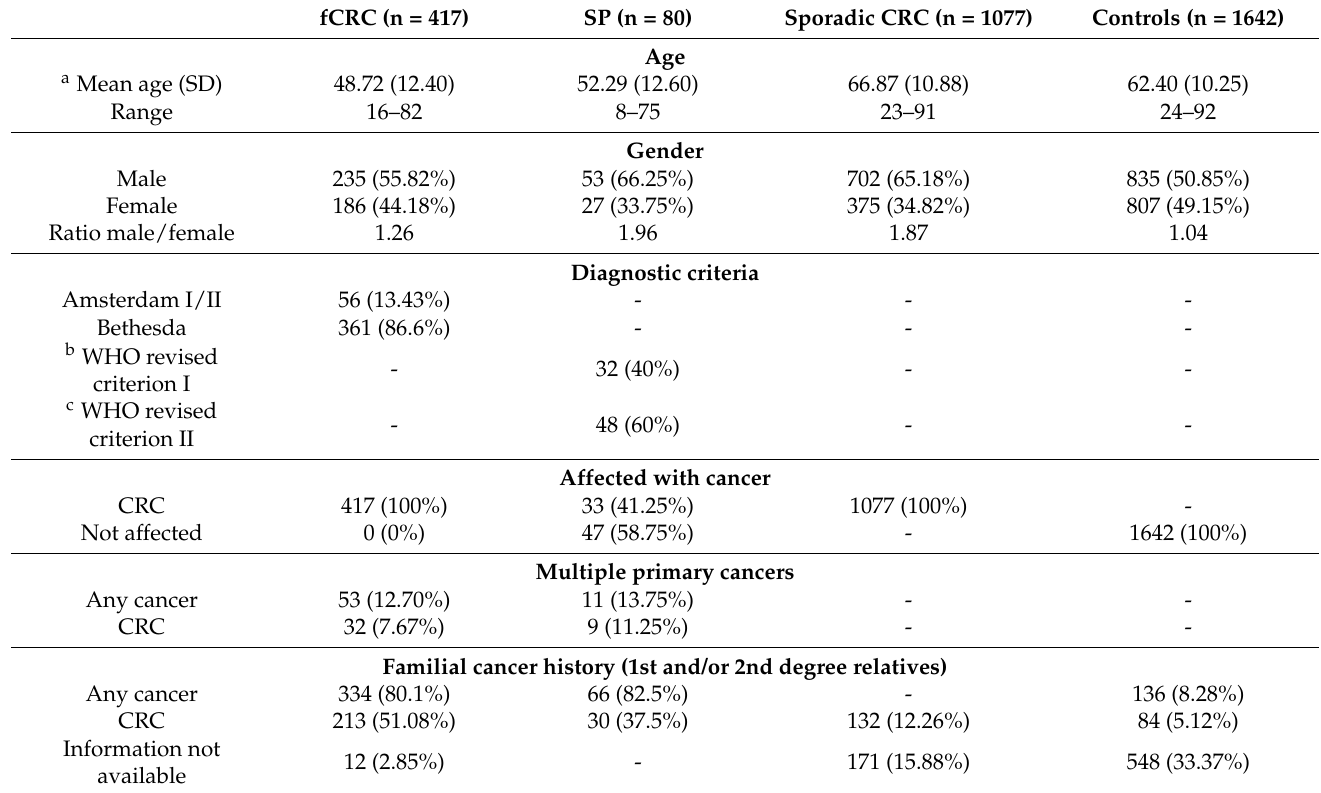
Table 1. Characteristics of the cases and controls included in the